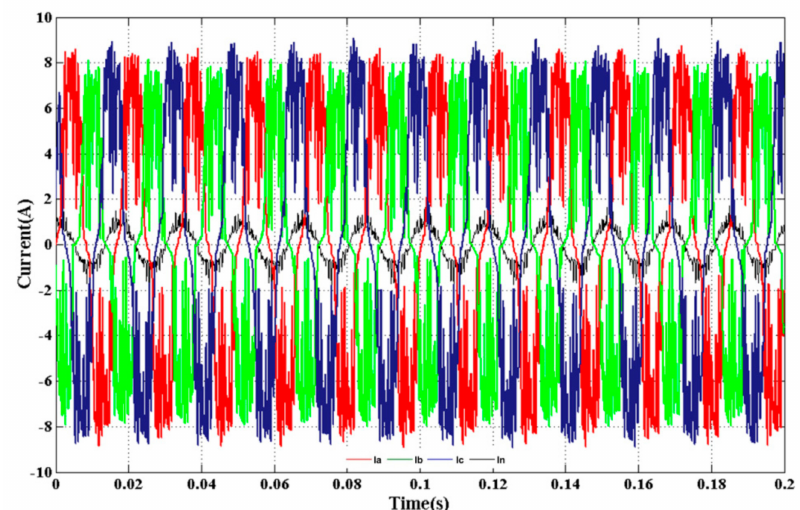
Figure 4. Source current before SAPF compensation for case 1.